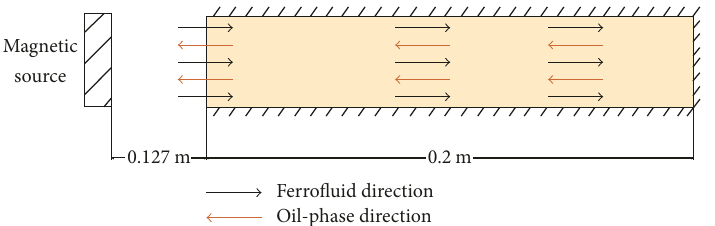
Figure 3: Magnet is placed on the left side of the core, with a core length, ℎ = 0.2 m, and magnet parameters, 𝑎 1 = 3×10 2 , 𝑏 1 = 3×10 −5 , 𝐵𝑟 = 1.19, 𝑎 = 𝑏 = 0.0254, 𝐿 = 0.127 m, and 𝜇 = 4𝜋10 −7 , and magnet positioned at 𝑥 = 0.2 m, 𝑦 = |𝑥 − 0.2| m. 0